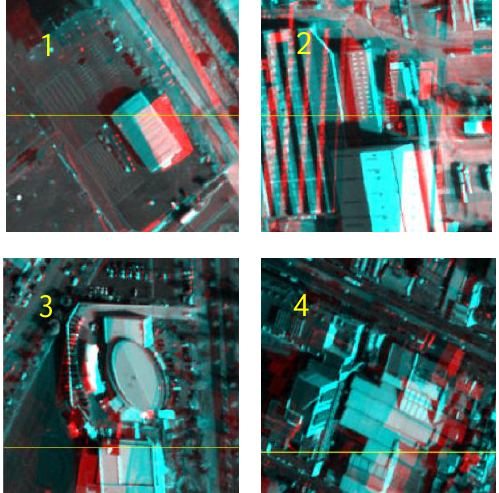
Figure 7. Sub-images at the corners of QuickBird anaglyph